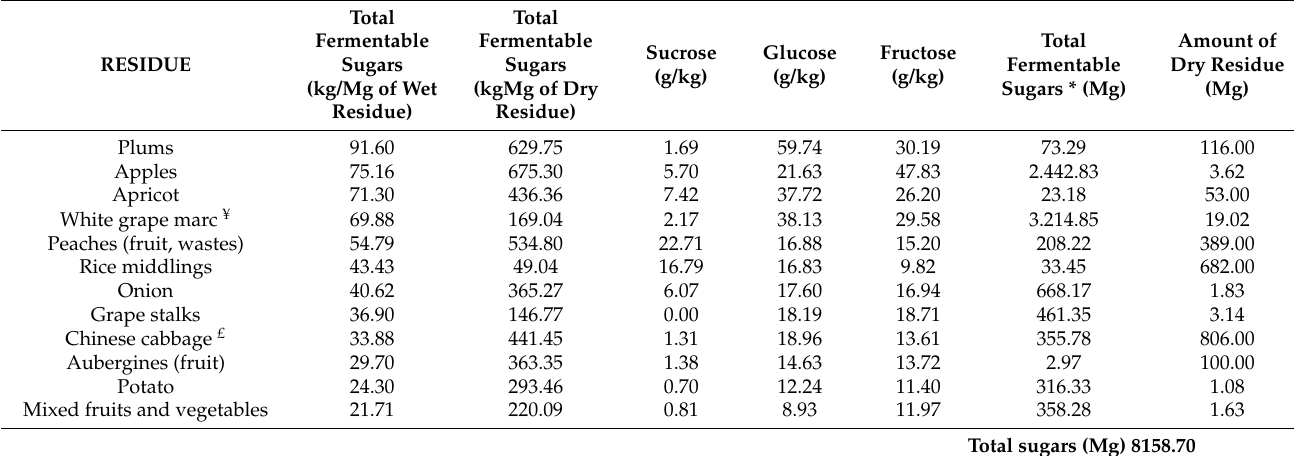
Table 3. Residues containing the higher amounts of sucrose, glucose, and fructose, and total yearly expected quantities of fermentable sugars. Results are reported as amounts per wet weight or, when reported, dry weight of the